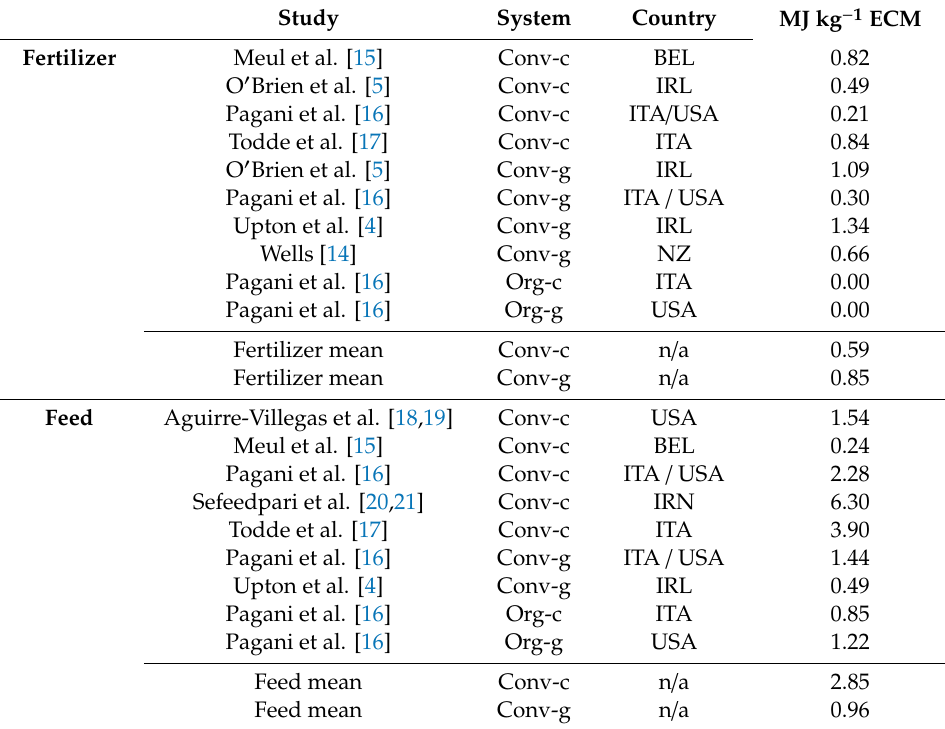
Table 2. Ancillary energy values found in